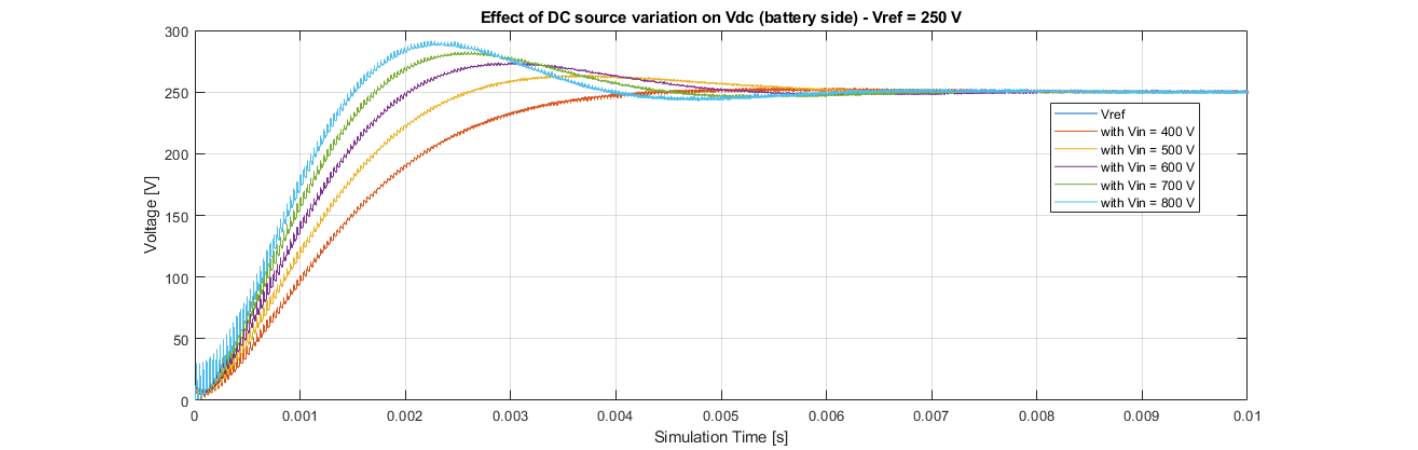
Figure 22. Effect of the V in variation on the output voltage control in the DAB converter, with V ref = 250